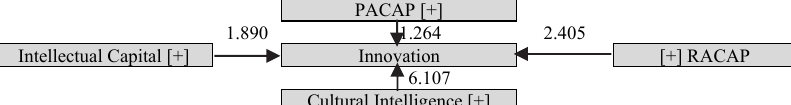
Fig. 3. The results of testing the